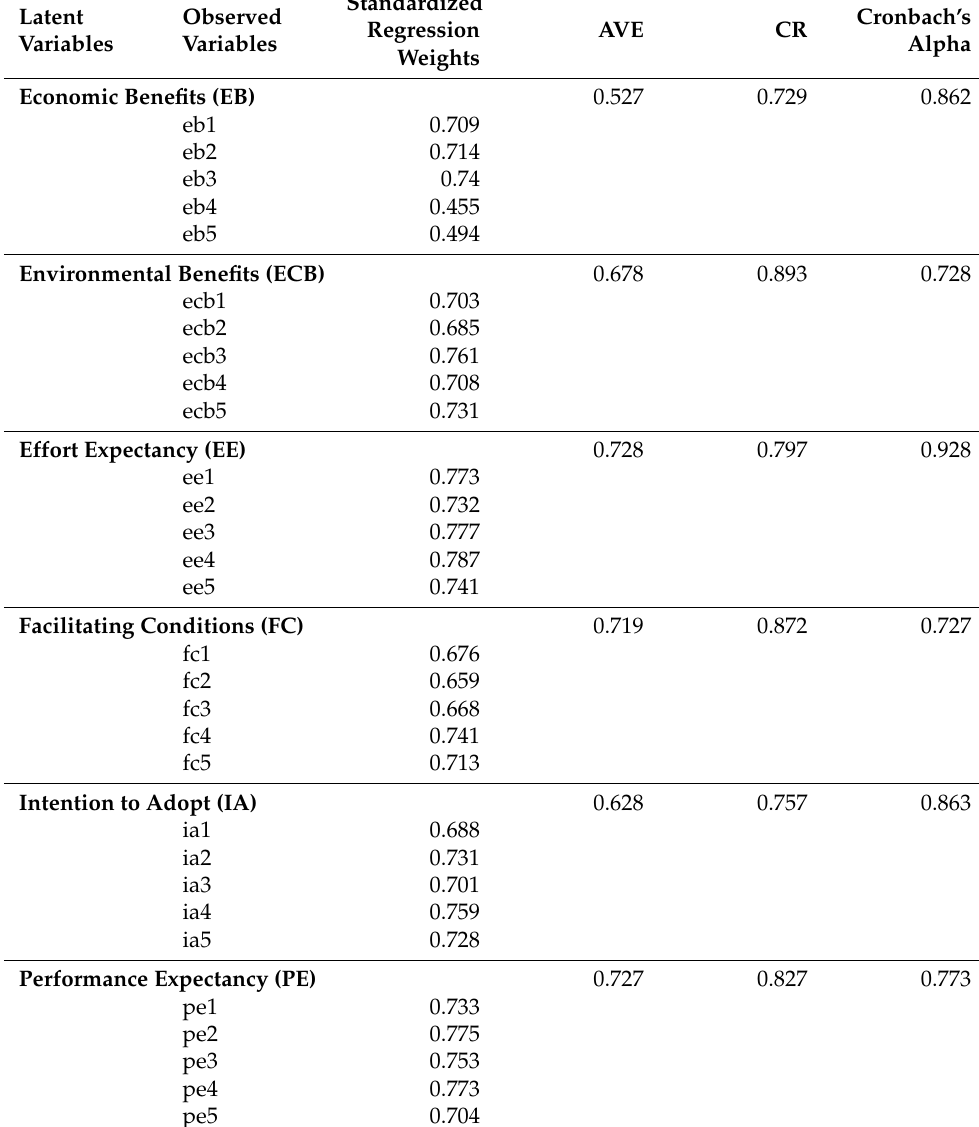
Table 1. CFA model